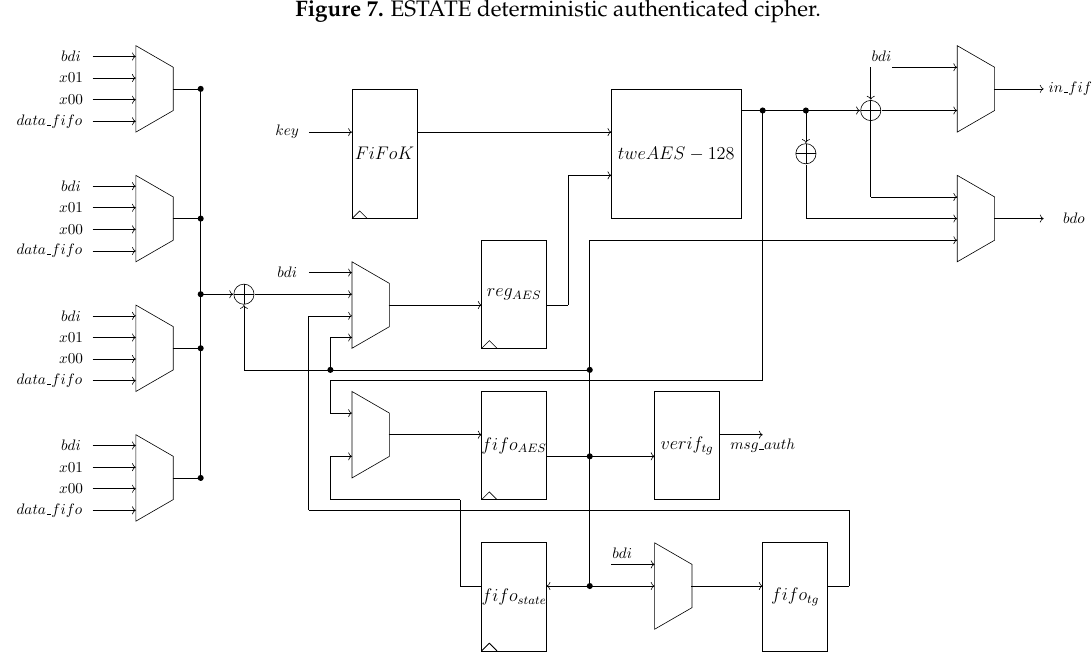
Figure 8. Architecture for